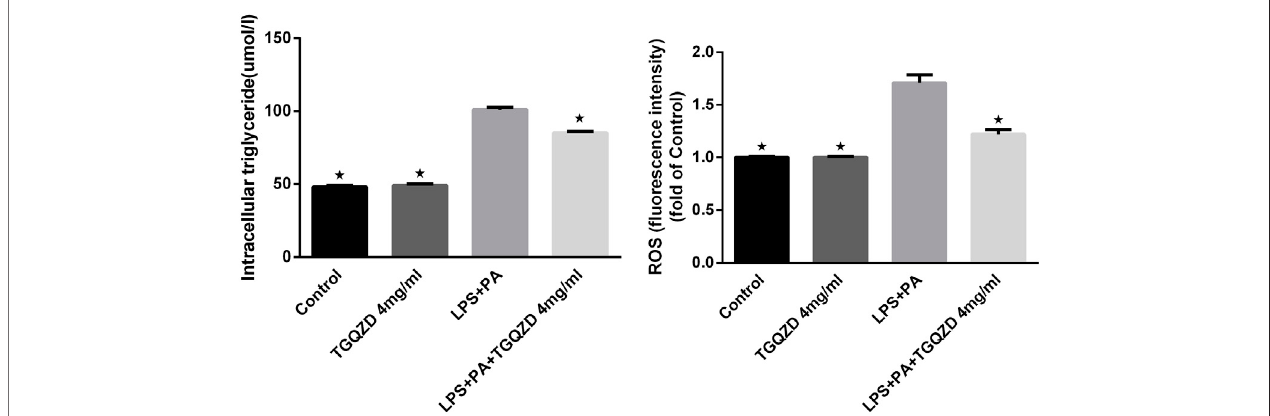
FIGURE6| EffectofwaterextractTGQZDontheformationofintracellulartriglyceride(TG)andreactiveoxygenspecies(ROS)inLPS+PA-treatedHepG-2cells.In the Control group, phosphate-buffered saline (PBS) in the culture medium; TGQZD group was treated with TGQZD in the culture medium; the LPS + PA group was treated with 10 μ g/ml LPS + 0.4 mMPA in the culture medium and the LPS + PA + TGQZD group was treated with 4 mg/ml TGQZD and 10 μ g/ml LPS + 0.4 mMPA in the culture medium, respectively. * p < 0.05 vs. LPS + PA Group,